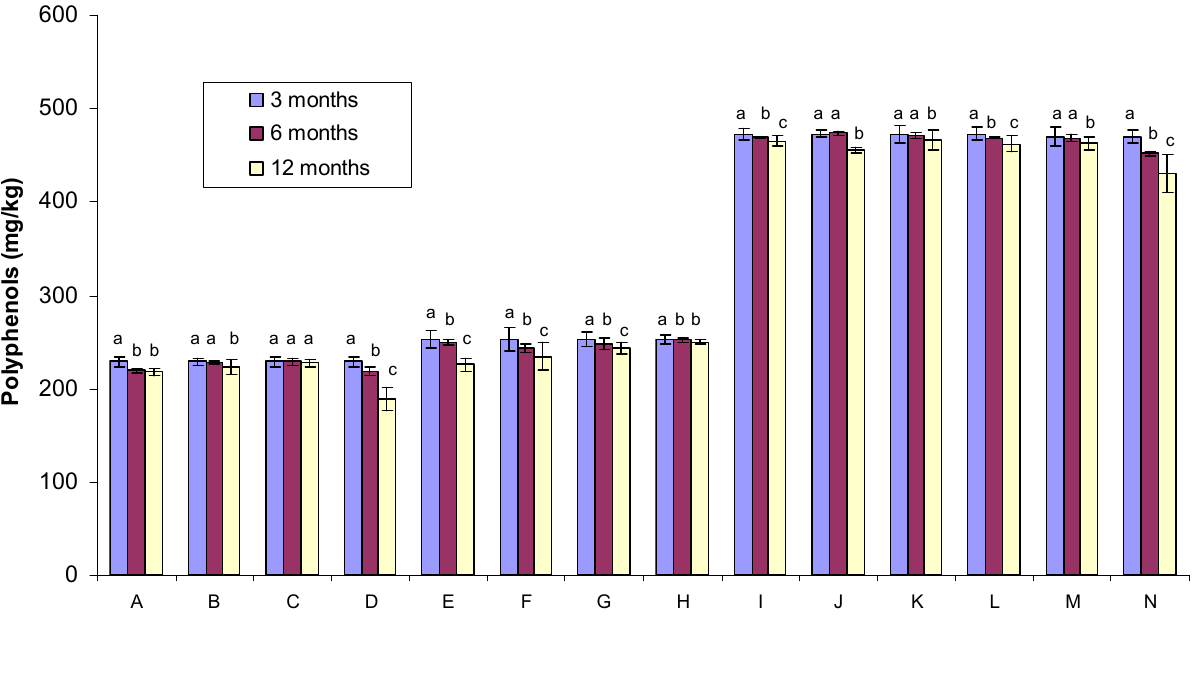
Figure 1. Comparison of the polyphenol content of Tualang honey samples exposed to different storage conditions (the data obtained after 6 and 12 months were compared with the base line data obtained after three months). Different letters (a, b and c) indicate significant differences ( p < 0.05). The letters “A” to “N” indicate the sample code (Table